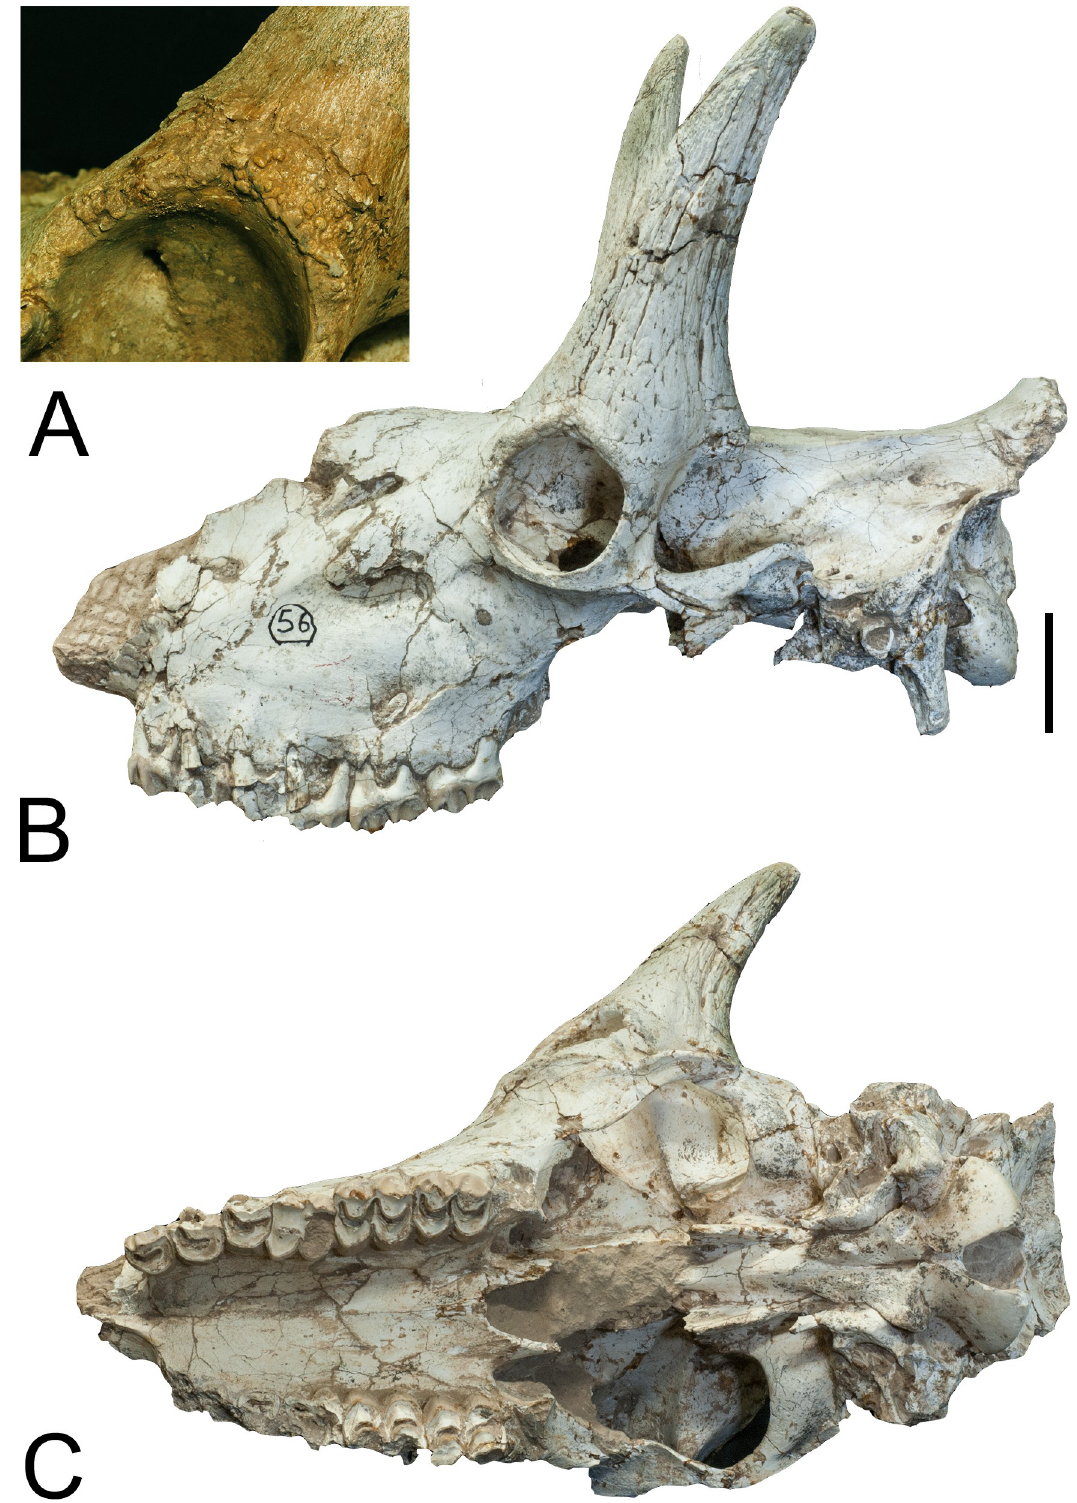
Fig 13. Samotherium boissieri. (A) IVPP V20167 base of left ossicone. (B) Lateral aspect of skull IVPP V20271. (C) Ventral view of skull IVPP V20271. Scale 50mm.